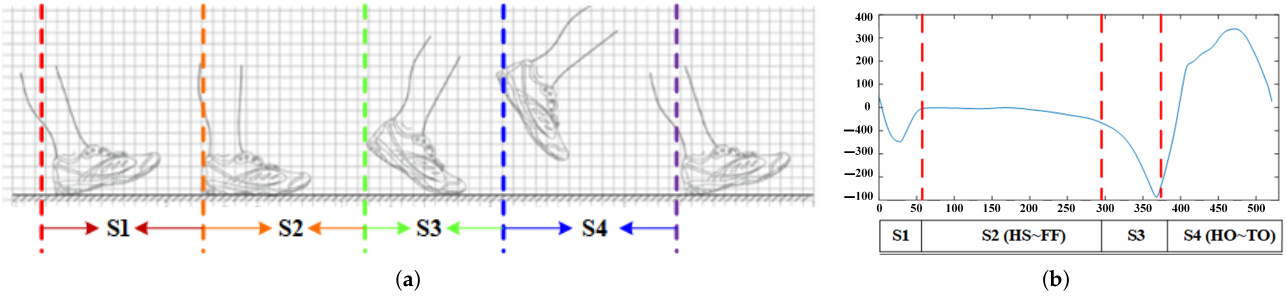
Figure 1. Traditional gait analysis methods ( a ) Correspondence between gait phases and Markov chain state ( b ) Correspon- dence between angular velocity and gait